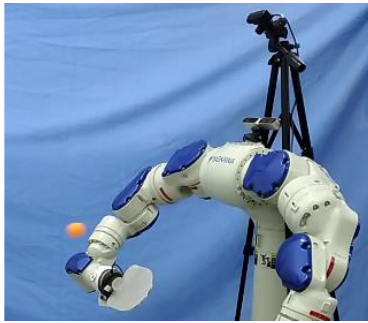
further studies using a robot to hit a Ping-Pong ball.